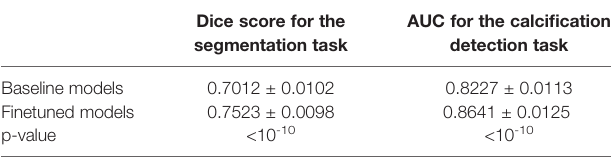
TABLE 1 | Experimental results of two breast cancer screening tasks. Dice score for the AUC for the calci fi cation segmentation task detection task Baseline